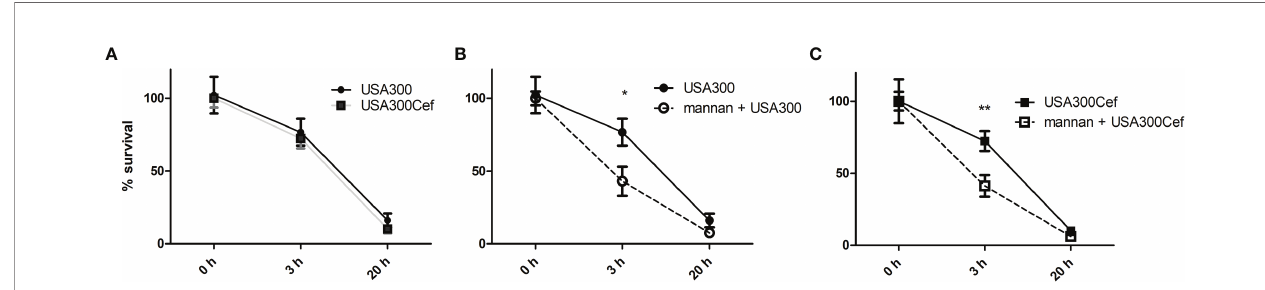
FIGURE 2 | Mannan increases the rate of endosomal killing of USA300. DCs were infected for 1 h with live USA300 (A, B) or cefoxitin-grown USA300 (A, C) at MOI 50. After 1 h of gentamicin (t = 0), DCs were incubated for 0, 3, and 20 h before cells were washed and lysed. CFU was counted from plated cell lysates and are shown as percentages compared to initial CFU (t = 0 h). Prior to addition of bacteria, cells were pre-treated or not (B, C) with mannan for 30 min. Data [average (SEM)] based on four pooled separate experiments. T-test, *p < 0.05, **p